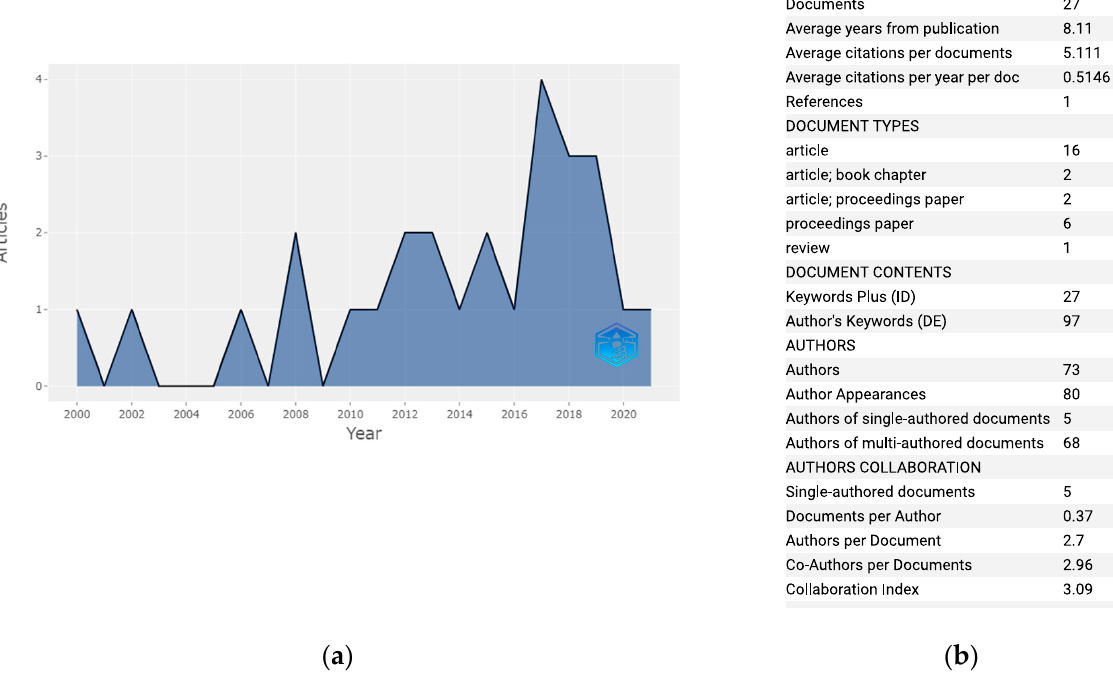
Figure 7. Word cloud of MC keywords.